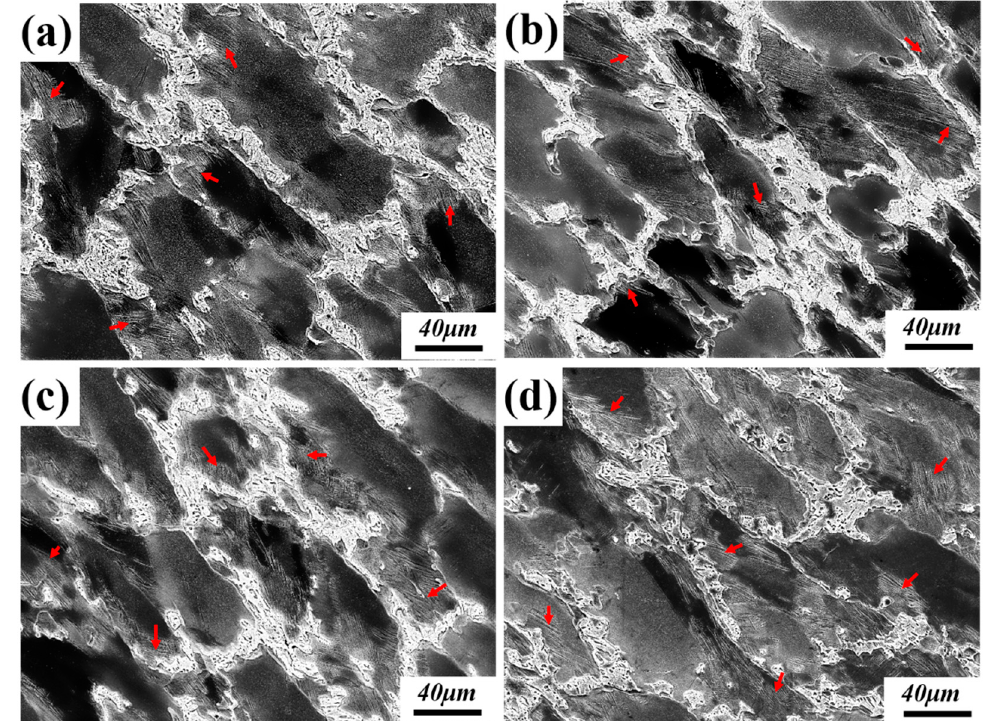
Figure 11. Microstructural evolution of the semi-solid CuSn10P1 alloy at 350 °C with different strain rates: ( a ) ε = 0.1 s − 1 , ( b ) ε = 1 s − 1 , ( c ) ε = 5 s − 1 , ( d ) ε = 10 s − 1 (arrows indicate deformation marks).